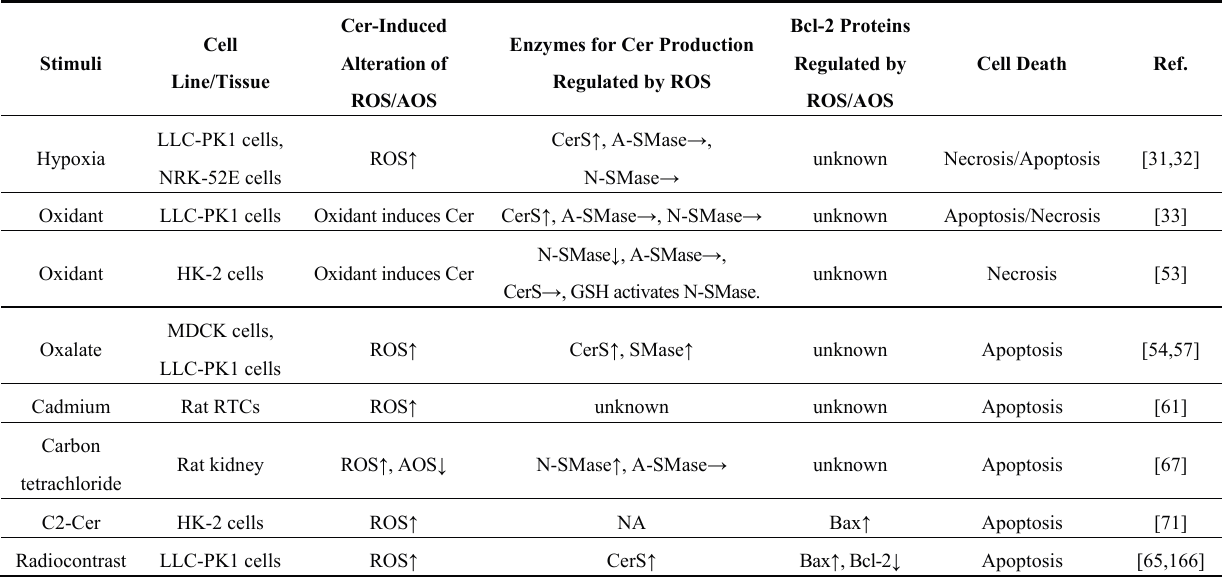
Table 3. Ceramide-induced ROS generation and ROS-induced regulation of the enzymes involving ceramide production and Bcl-2 family proteins in RTCs